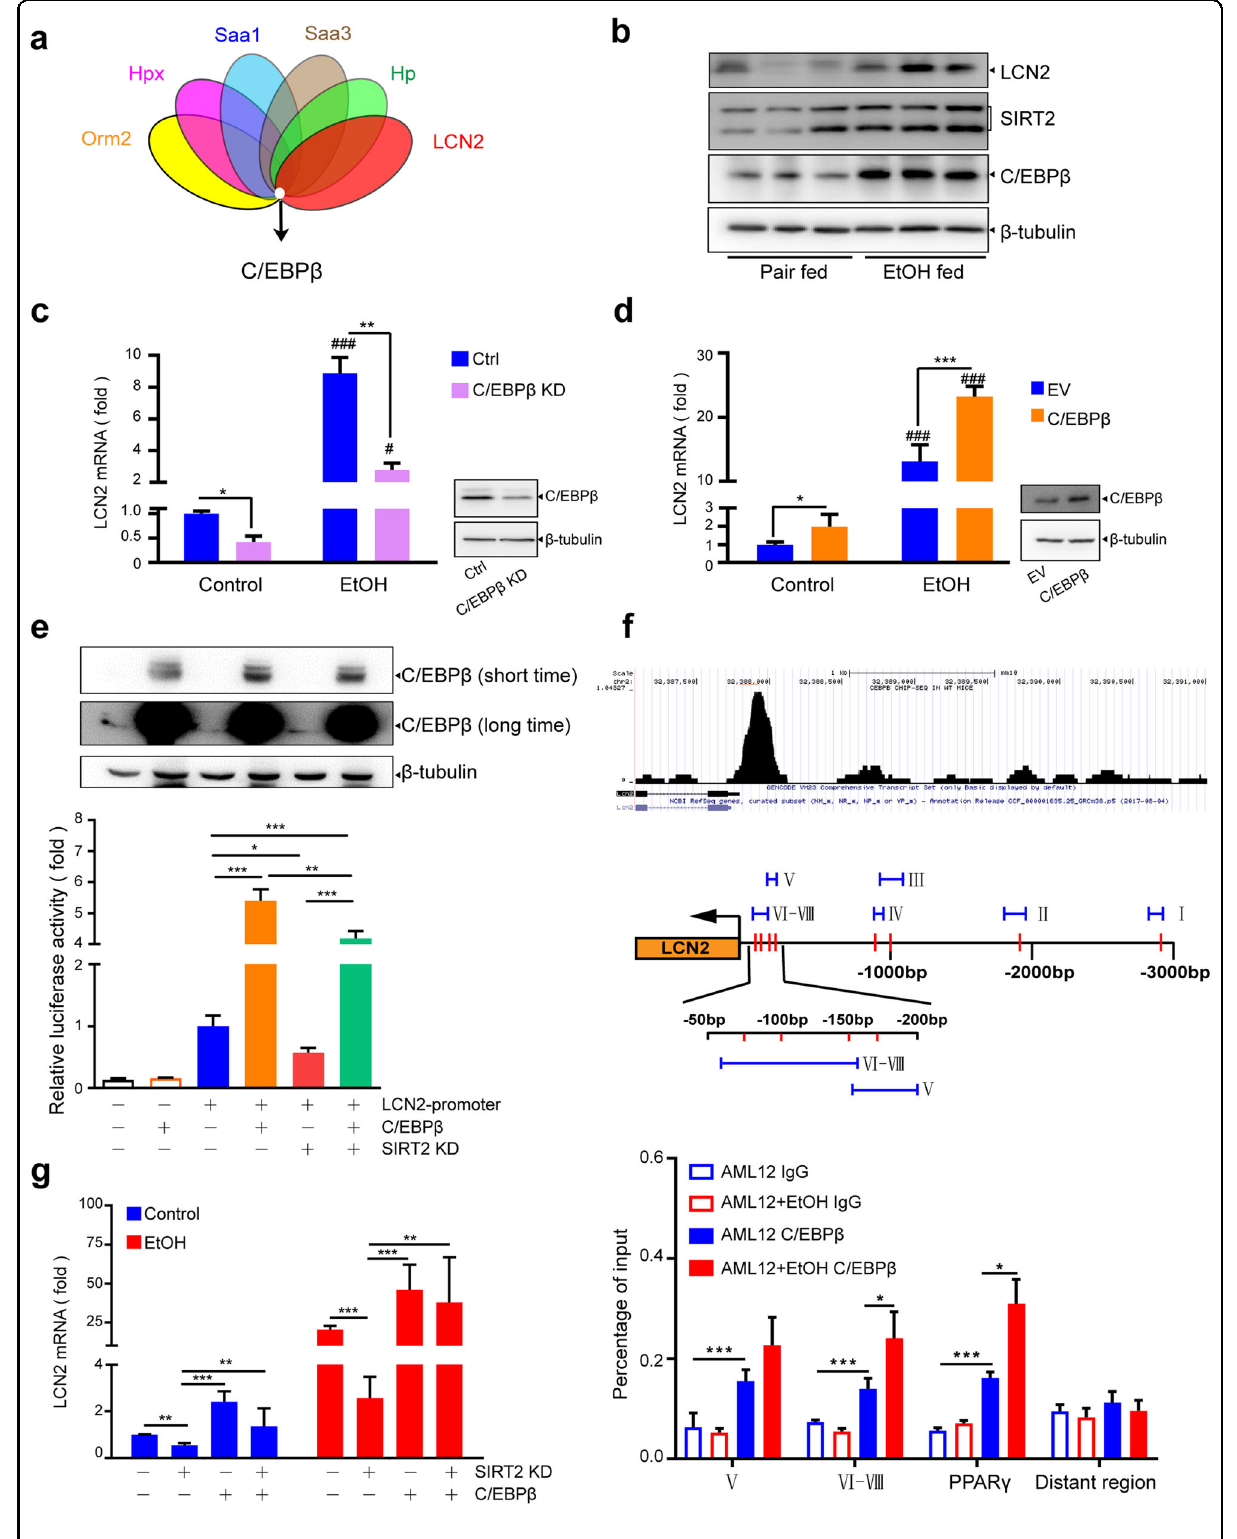
Fig. 5 (See legend on next